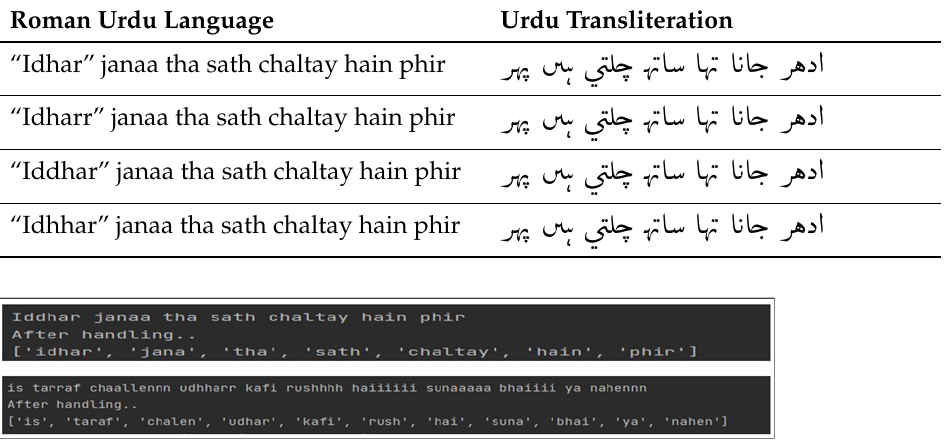
Table 3. Colloquial Roman Urdu variants.